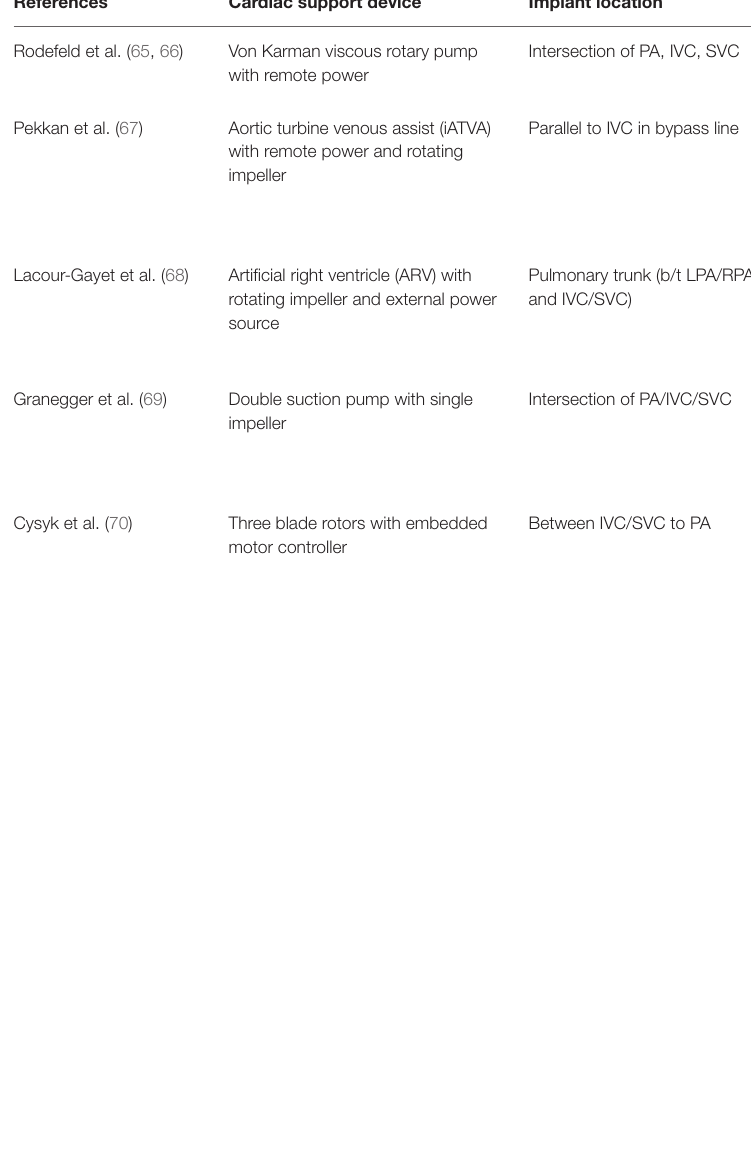
TABLE 2 | Mechanical support devices under development for implantation within the total cavopulmonary connection in patients with Fontan circulation in an effort to assist pulmonary